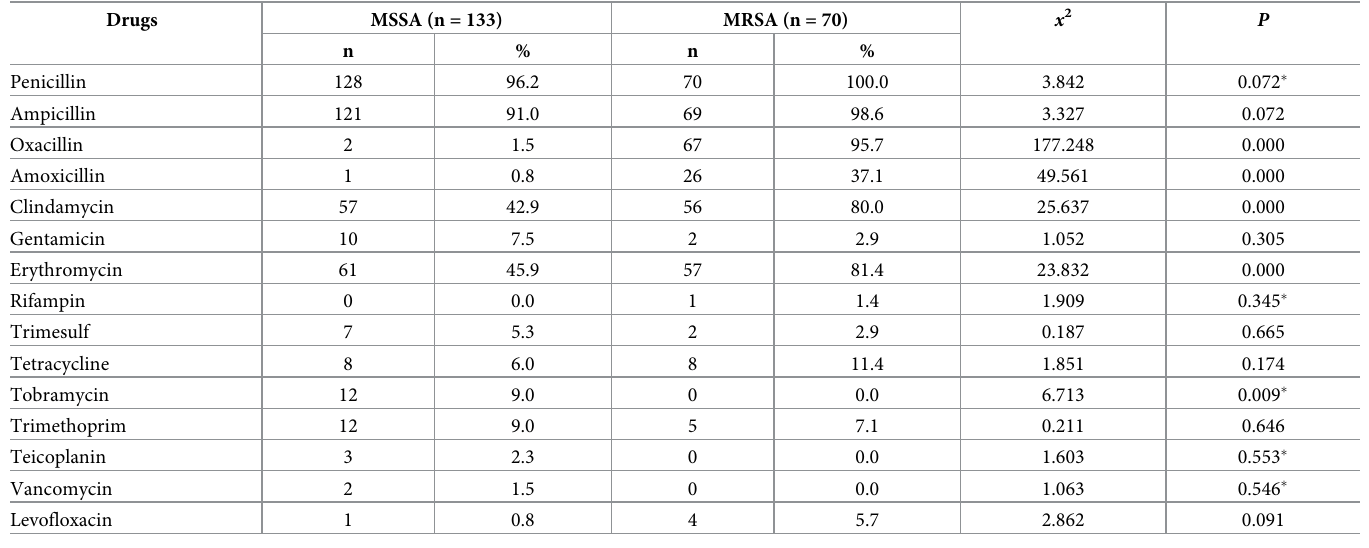
Table 2. Drug resistance of Staphylococcus aureus.